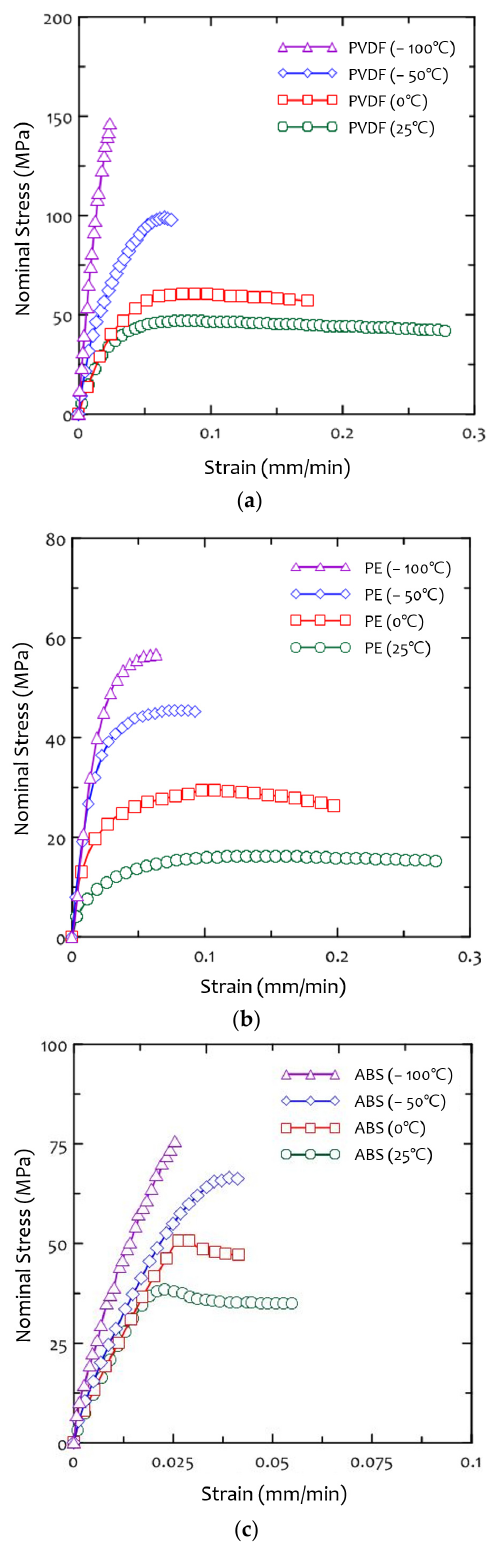
Figure 3. Temperature-dependent stress-strain curves of the polymers: ( a ) PVDF, ( b ) PE, and ( c ) ABS.